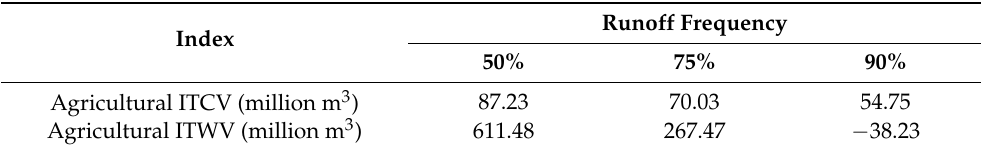
Table 7. The ITWV and the ITCV of agriculture in Changsha city under different runoff frequencies in